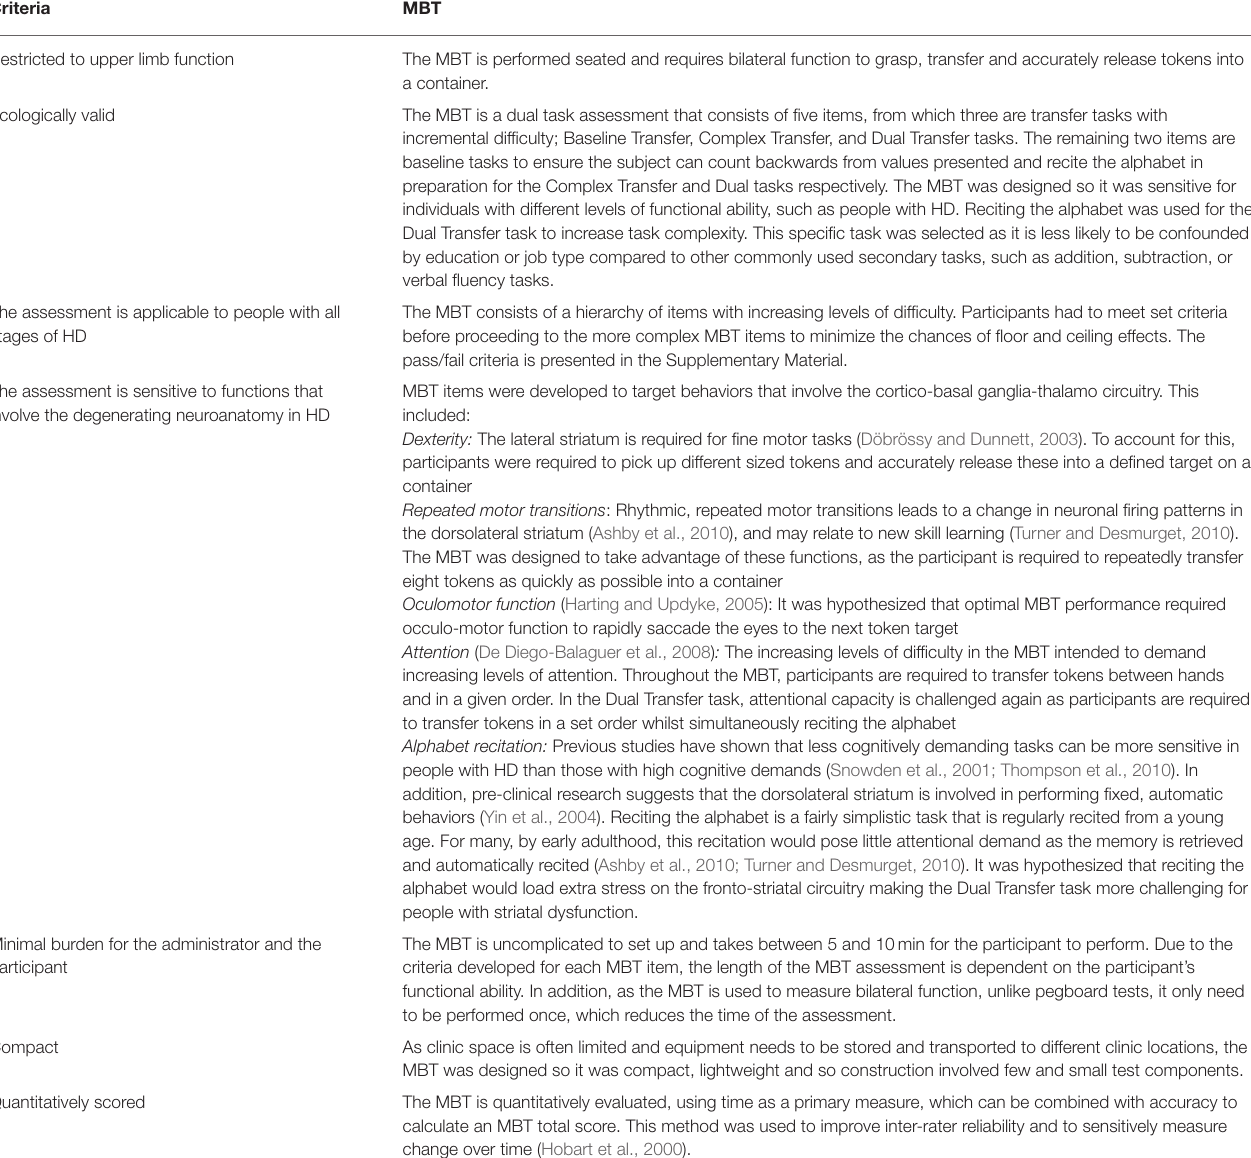
TABLE 1 | Criteria used to develop the MBT.